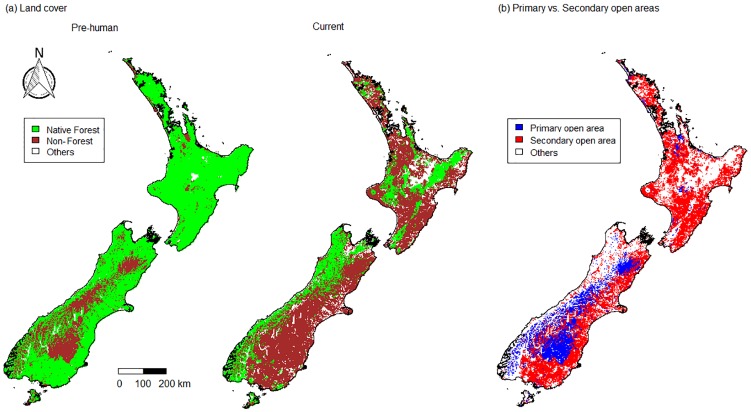
Forest and open land cover in New Zealand since human settlement.(a) Maps of forest and non-forest land cover in pre-human and current times. Forest (green) and non-forest, i.e., open (brown) land cover that were modelled for pre-human times in the 13th century [21] and observed for current times in 2012 [22] are shown. (b) A map of primary and secondary open areas. Primary open areas (blue) indicate areas that were forest-free prior to human settlement and are still open today; secondary open areas (red) are areas that were forested prior to human settlement but that are currently characterised by open habitat. In these figures, “Others” (white) indicates areas that are currently not open habitat or are considered unsuitable for our target species (e.g., urban area and waterbodies).